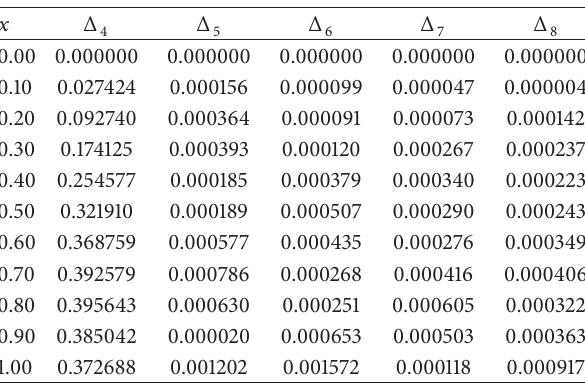
Table 9: Δ 𝑁 = |𝑓 ∗ 𝑁 (𝑥) − 𝑓 ∗ 𝑁+1 (𝑥)| of Example 6 for 𝑁 = 4,5,6, 7, 8 of Genocchi